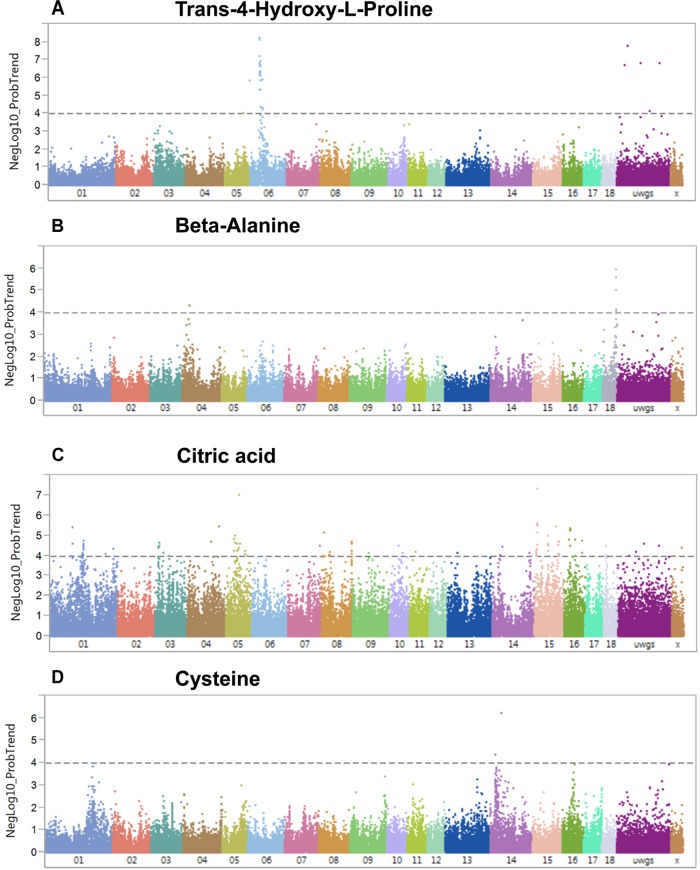
Manhattan plots visualizing genome wide associations of SNPs and metabolites (mQTL). (A) Trans-4-hydroxy-L-proline, (B) beta-alanine, (C) citric acid, and (D) cysteine. The dotted line depicts the genome-wide significance thresholds at negative log 10 > 4.